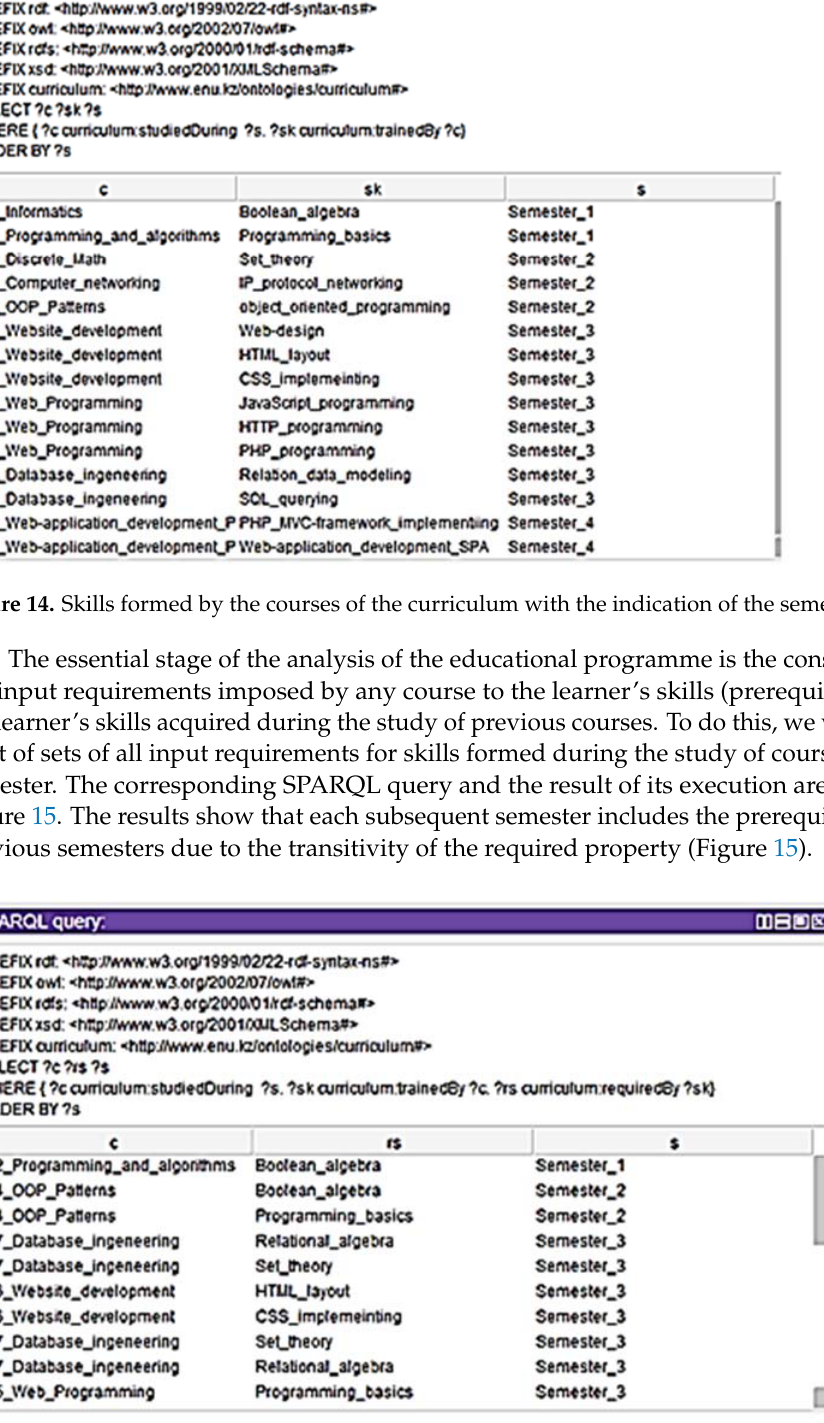
Figure 13. The list of courses in the curriculum with the indication of the semester.